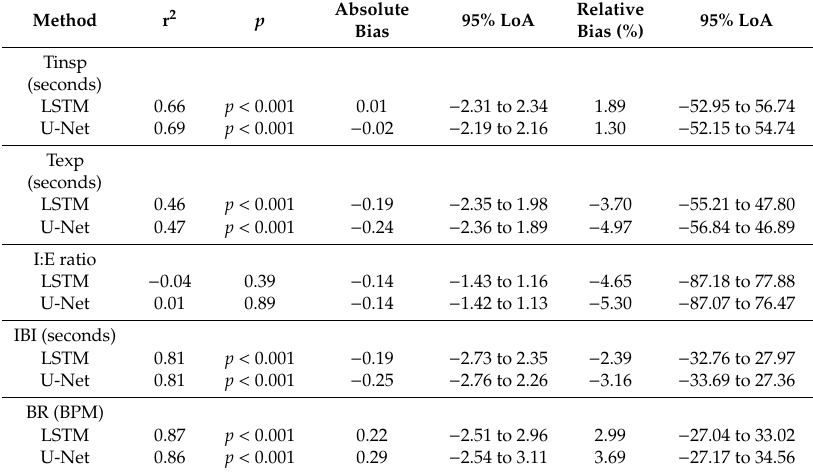
Derived breathing metrics using the LSTM and U-Net methods and associated statistical analyses.